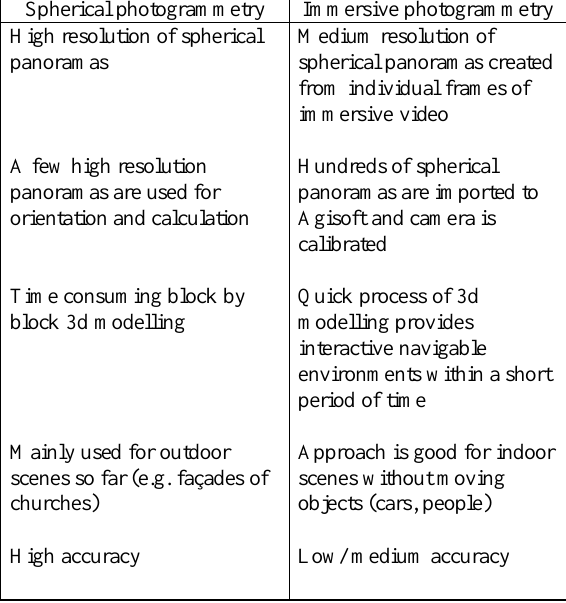
Table 3. Comparison between spherical photogrammetry and immersive photogrammetry proposed in this paper.